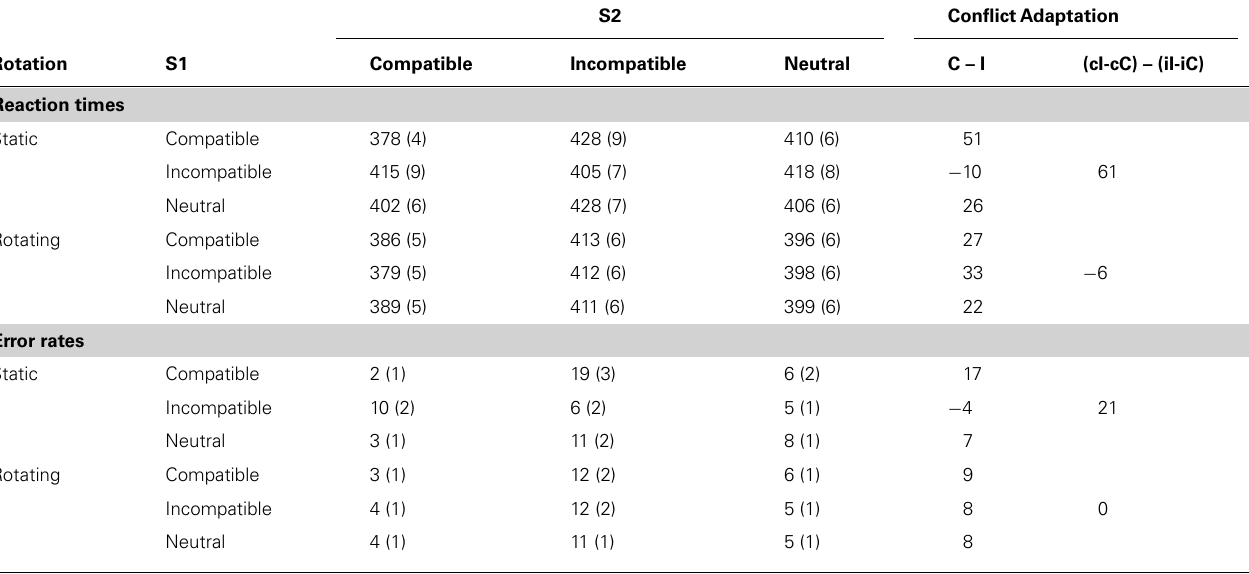
Table 2A | Experiment 2, compatibility and conflict-adaptation results.